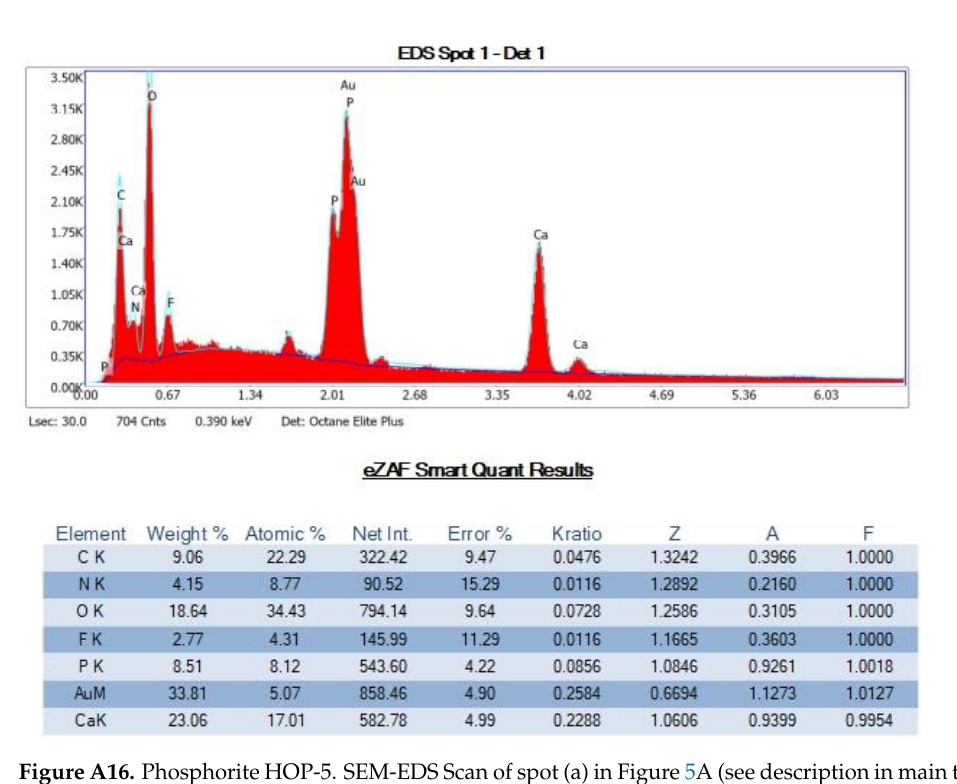
Figure A16. Phosphorite HOP-5. SEM-EDS Scan of spot (a) in Figure 5A (see description in main text).